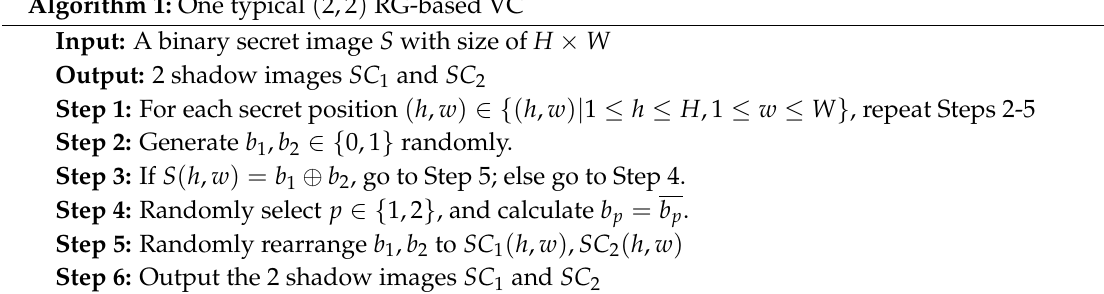
Algorithm 1: One typical ( 2, 2 ) RG-based VC